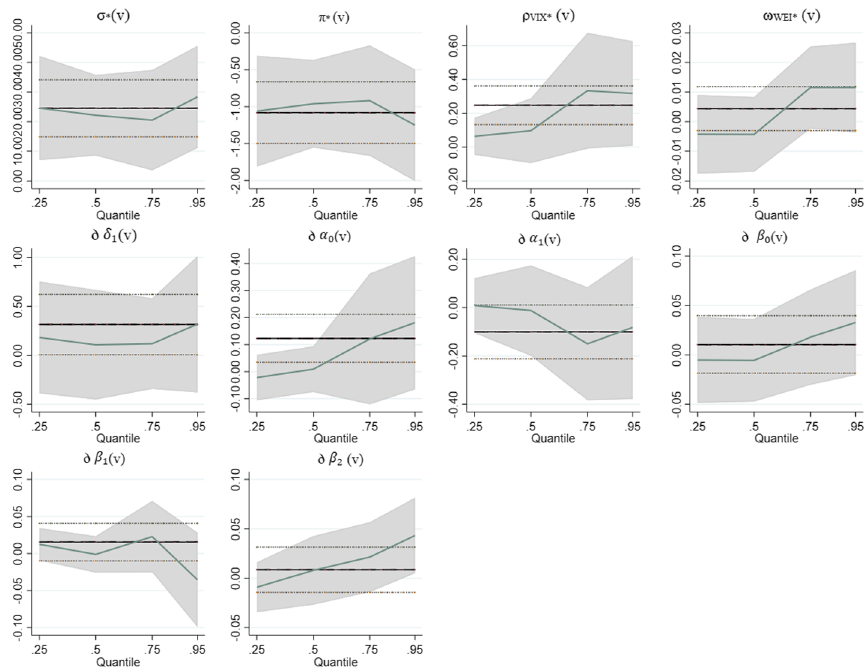
Fig. 2 95% confidence intervals of the QARDL model parameters. Horizontal axis indicates the quantile levels (v < 0.5, 0.5 < v < 0.75, 0.75 < v < 0.95). Vertical axis indicates coefficient estimates of